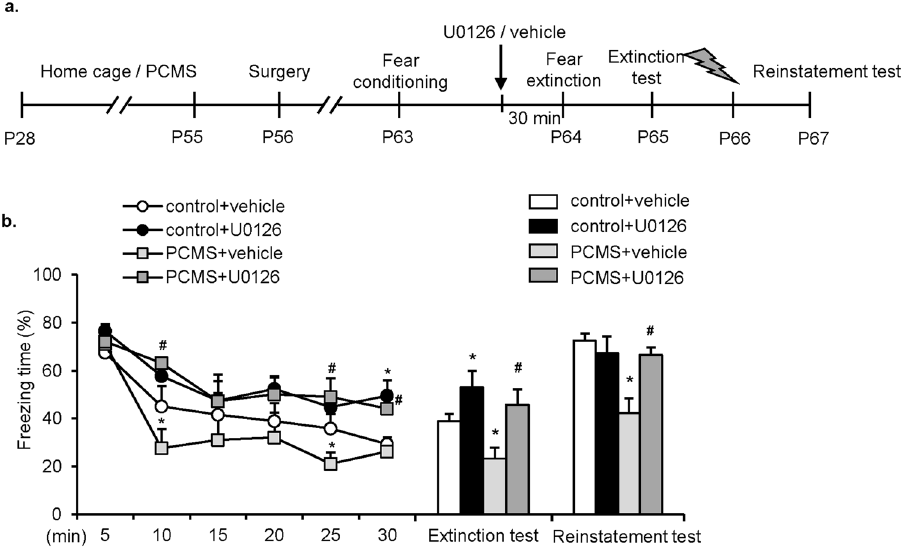
Figure 5. Intra-IL infusion of the ERK1/2 inhibitor U0126 reversed the PCMS-induced enhancement of fear extinction. ( a ) Experimental timeline. ( b ) U0126 blocked the effect of PCMS on extinction, extinction retention, and reinstatement. The data are expressed as the mean ± SEM ( n = 8–10 per group). * p < 0.05, compared with control + vehicle group; # p < 0.05, compared with PCMS + vehicle